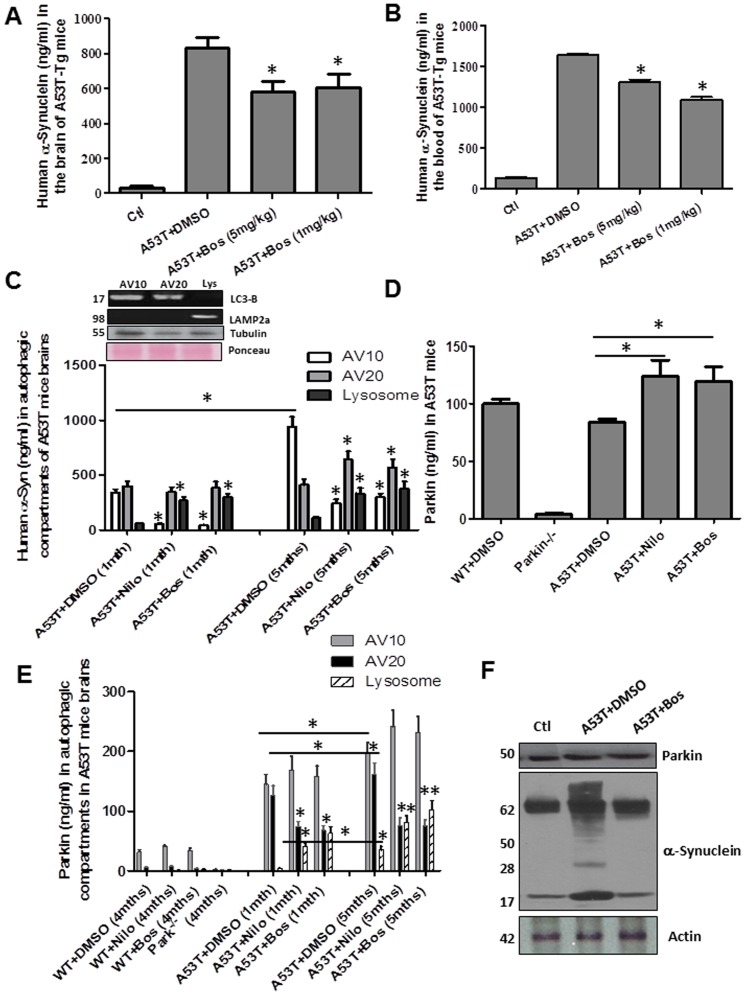
TKIs stimulate autophagic α-Synuclein clearance in A53T mice.ELISA measurement of human α-Synuclein in the A) brain and B) blood of 1 month old A53T mice injected I.P. with either 5 mg/kg or 1 mg/kg bosutinib once every other day for 6 weeks (n = 10). C). Insert shows separation of AVs and lysosomal fractions. Histograms represent subcellular fractionation of total brain lysates from A53T mice and ELISA of human α-Synuclein in AVs in 1 and 5 months old A53T brains after daily I.P. injection with 10 mg/kg nilotinib or 5 mg/kg bosutinib for 3 weeks (n = 5). D). ELISA showing parkin level in total brain extracts of A53T mice compared to WT and parkin−/− in the presence of nilotinib and bosutinib (n = 10). E). Histograms represent subcellular fractionation of total brain lysates from A53T mice and parkin ELISA in AVs in 1 and 5 months old A53T brains after daily I.P. injection with 10 mg/kg nilotinib or 5 mg/kg bosutinib for 3 weeks (n = 5). Asterisk indicates significantly different, means±SEM, ANOVA, Newman Keuls. F) WB analysis on 4−12% NuPage SDS gel showing parkin and α-Synuclein levels relative to actin in A53T mice treated with either DMSO or bosutinib.